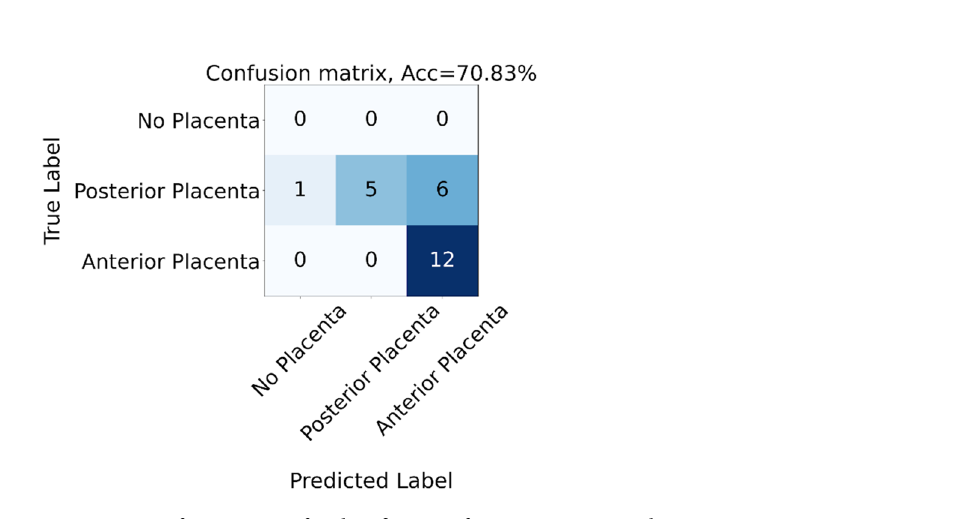
Figure 1. Confusion matrix for classification of anterior/posterior